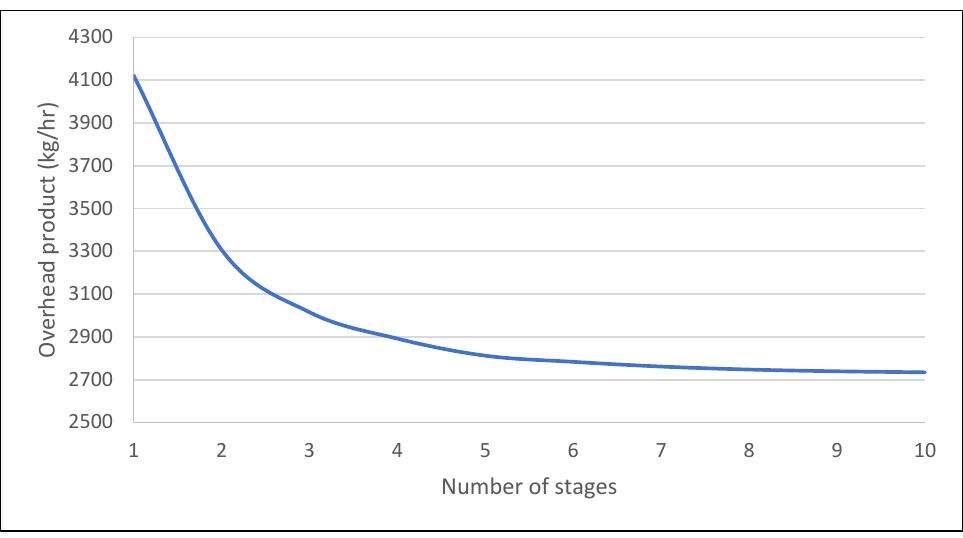
Figure 1. Effect of the stripper stage number on the flow rate of the overhead product.